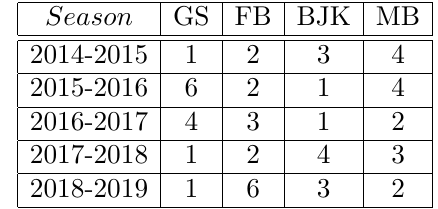
Table 2. Total number of games the favorite teams played on different days between 2014 and